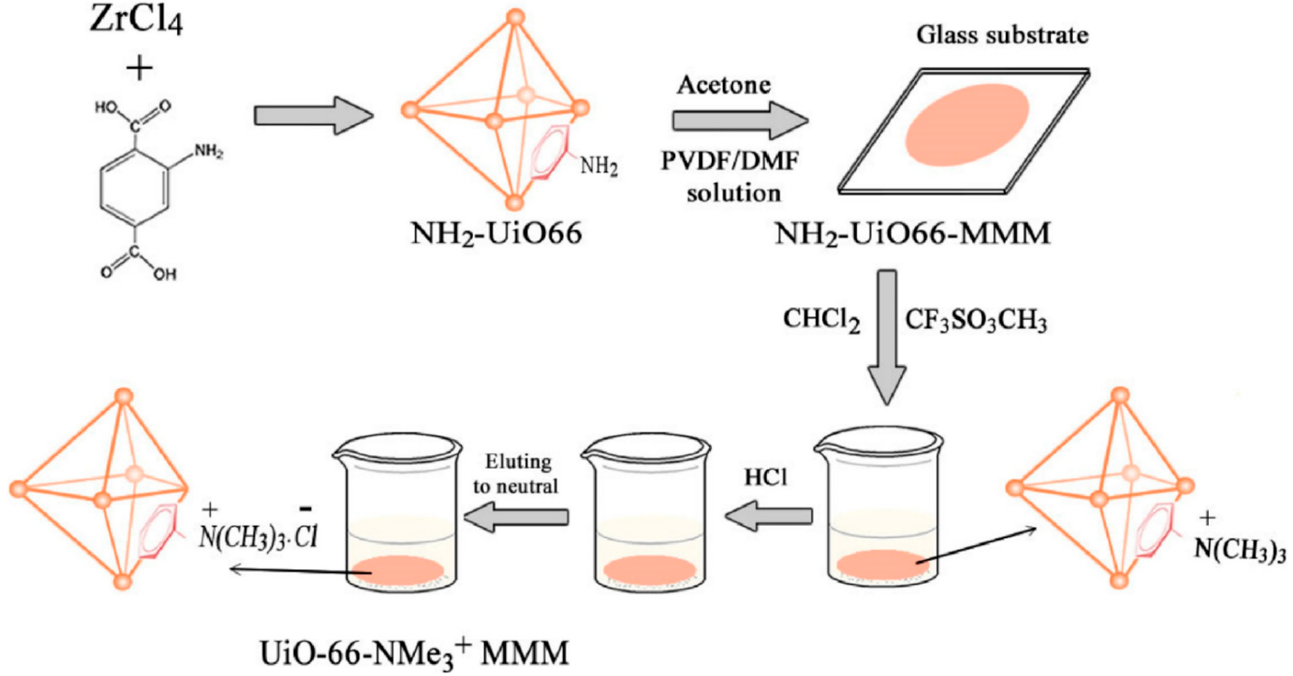
Figure 3. Illustration for the synthesis of the UiO-66-NMe 3+ MMM. Reprinted with permission from Ref. [88]. Copyright (2020) Elsevier.